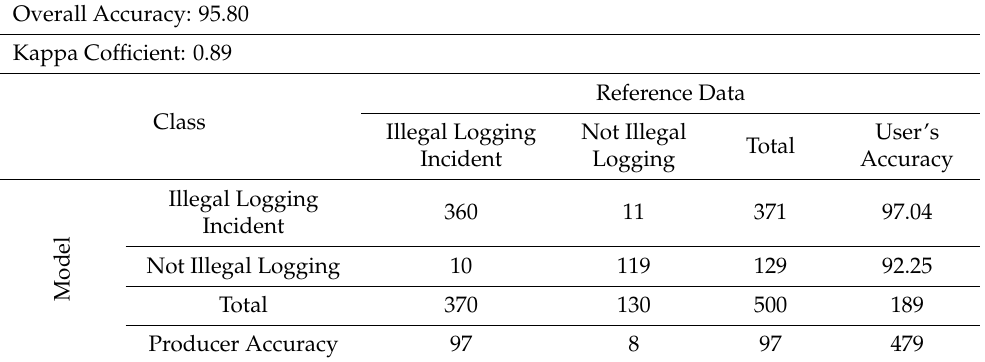
Figure 8. Layer catch of illegal logging incidents in Sulawesi Selatan: ( a ) authorities confiscated illegal logging timbre in East Luwu Regency, ( b ) illegal logging actors made roads for illegal timbre skidding in Takalar Regency, ( c ) confiscation of illegal logging timbre in Gowa Regency, and ( d ) illegal logging of forests to be converted into pepper plantations in East Luwu Regency. Table 1. Confusion matrix for illegal logging classified